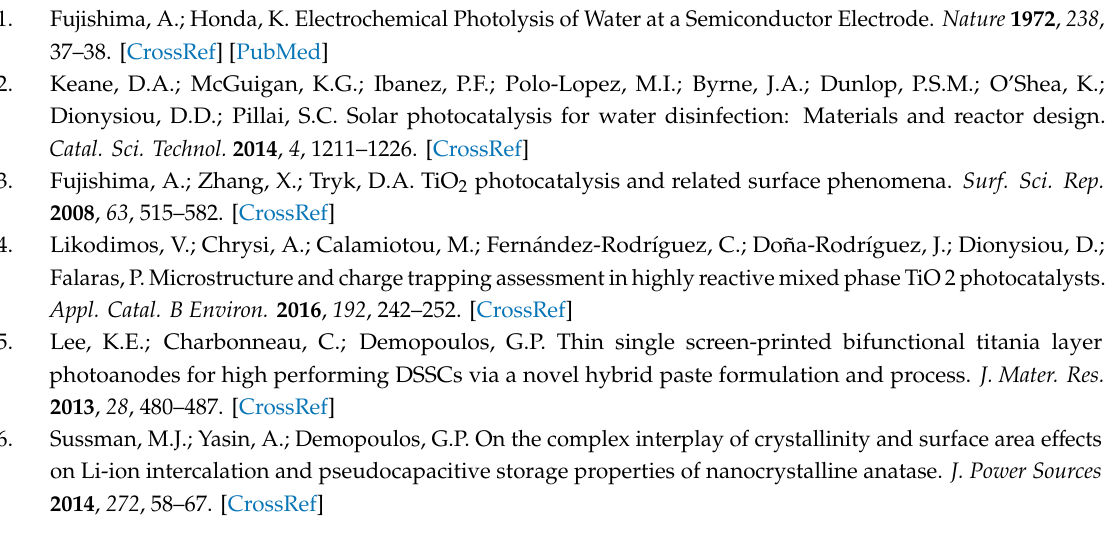
2 materials; Table S3:% OH content derived from determination of the –OH% spectroscopic parameter; Table S4: First-order* photocatalytic reaction rate constants of synthesized mixed-phase nanoTiO 2 ; Table S5: Bandgap comparison of synthesized pure-phase Anatase, Brookite and Rutile TiO 2 nanoparticles with synthesized mixed-phase TiO 2 nanoparticles; A / b , B / r , R / b ; Scheme S1: Synthesis of TiO 2 in continuous stirred tank reactor by forced hydrolysis of aqueous TiCl 4 solution; Scheme S2: Simplified molecular structure of methyl orange; Scheme S3: Scheme representation of the UV photocatalytic reactor in a